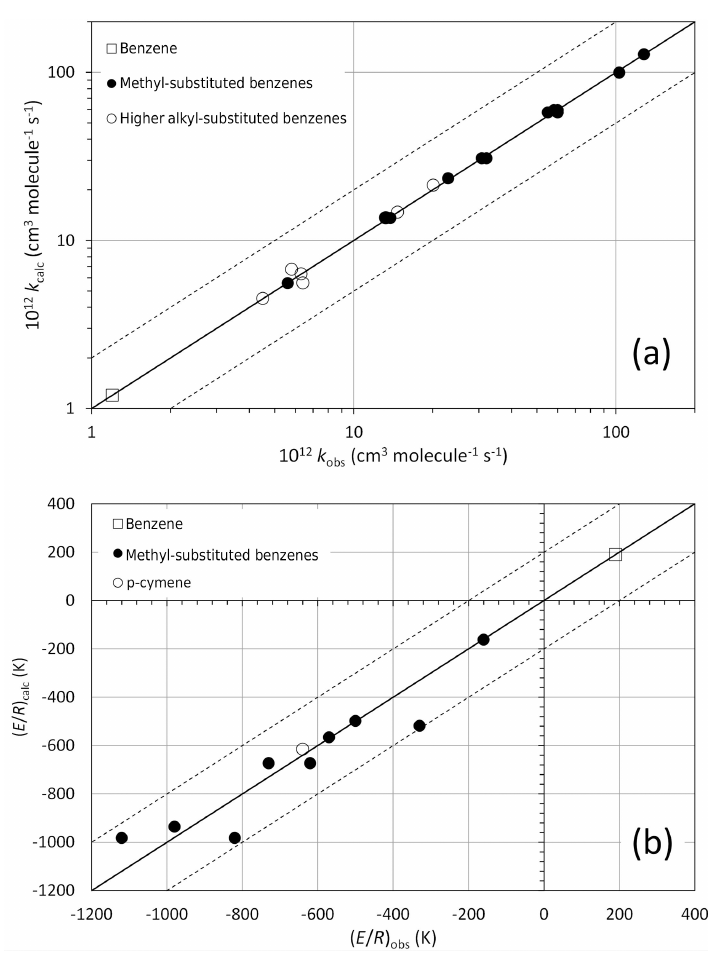
Figure 1. (a) A log–log correlation of k calc and k obs at 298K for benzene, methyl-substituted benzenes and higher alkyl-substituted benzenes. The broken lines show the factor of 2 range. (b) A correlation of the temperature coefficients ( E/R) calc and ( E/R) obs for the same compound classes. The broken lines show the ± 200K